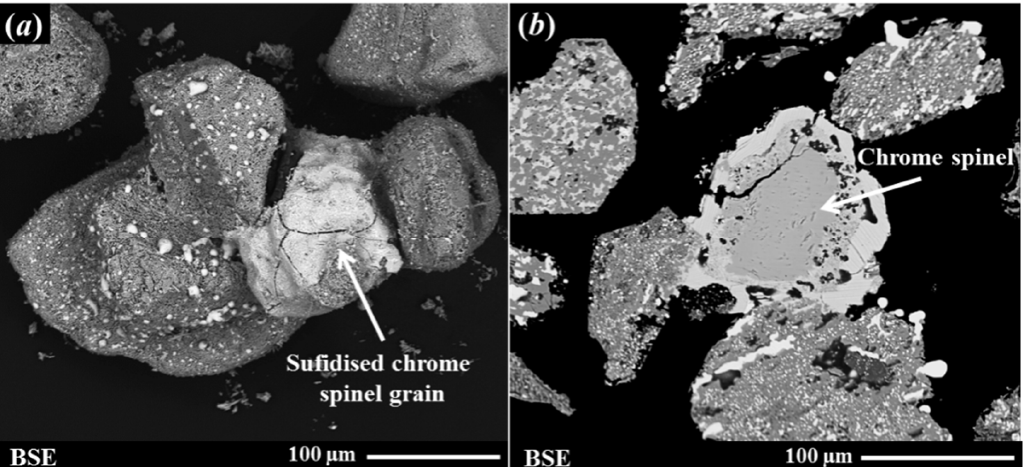
Figure 2. Secondary electron (SE) and back-scattered electron (BSE) images showing clustered grains of reduced ilmenite and sulphidised chrome spinel grains: ( a ) an SE image showing the surface morphology of sulphidised chrome spine grains; ( b ) a BSE image showing a sectioned and polished cross-section of particles.